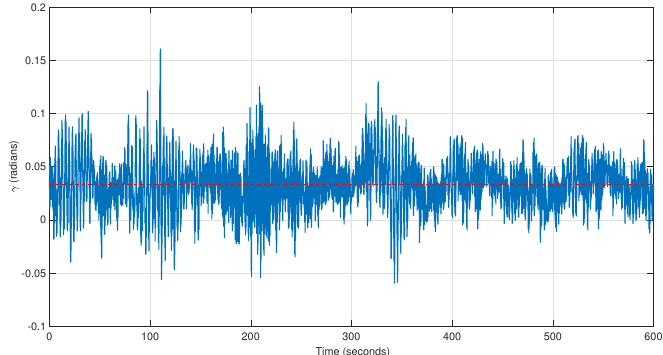
Figure 10. Deviation γ for rated wind speed (10 m/s).